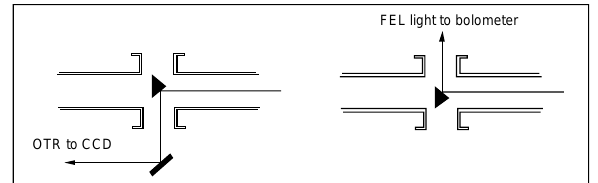
FIG. 10. Schematic layout of diagnostics. On the left, the triangular mirror is positioned in the vacuum chamber generate optical transition radiation (OTR), which is guided out of a periscope to a charge-coupled device (CCD) camera. On the right, the triangular mirror is positioned to guide FEL light to a power